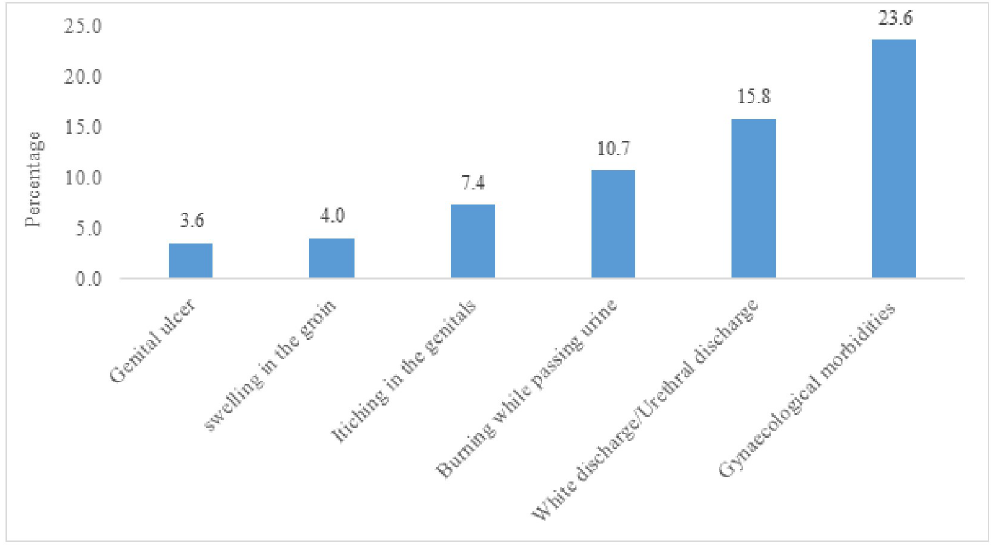
Fig 1. Percentage of adolescent girls who reported gynaecological morbidities in three months prior to the survey year.